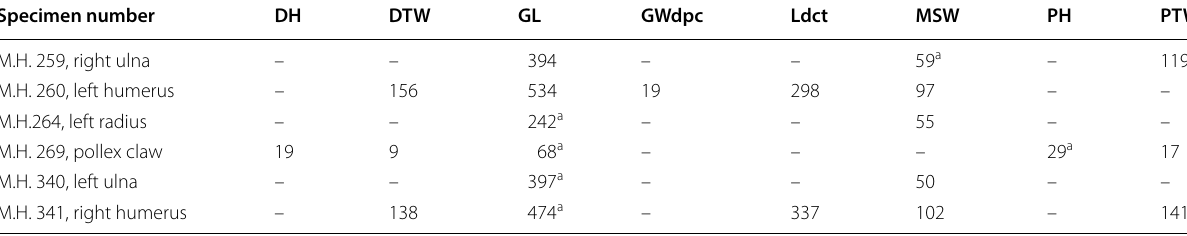
DH distal height (applies only to ungual phalanges), DTW distal transverse breadth, GL greatest length, GWdpc greatest width of deltopectoral crest (applies only to humerus), Ldct distance from distal end to start of dpc (applies only to humerus), MSW minimum shaft width, PH proximal height (applies only to ungual phalanges), PTW proximal transverse breadth. All measurement are in mm a Indicates that the measurements refers only to preserved dimension at the incomplete bone